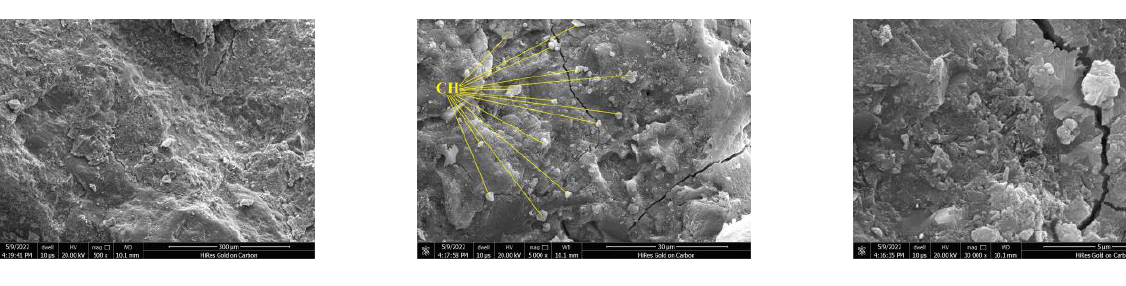
Figure 17. SEM micrographs of OPC (×500; ×5000; ×30,000).